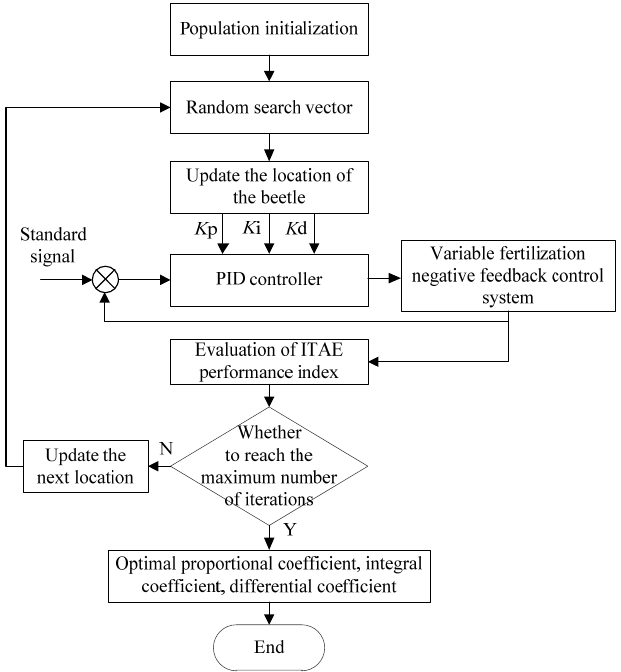
Figure 4. Flowchart of optimizing PID parameters by beetle antennae search algorithm.